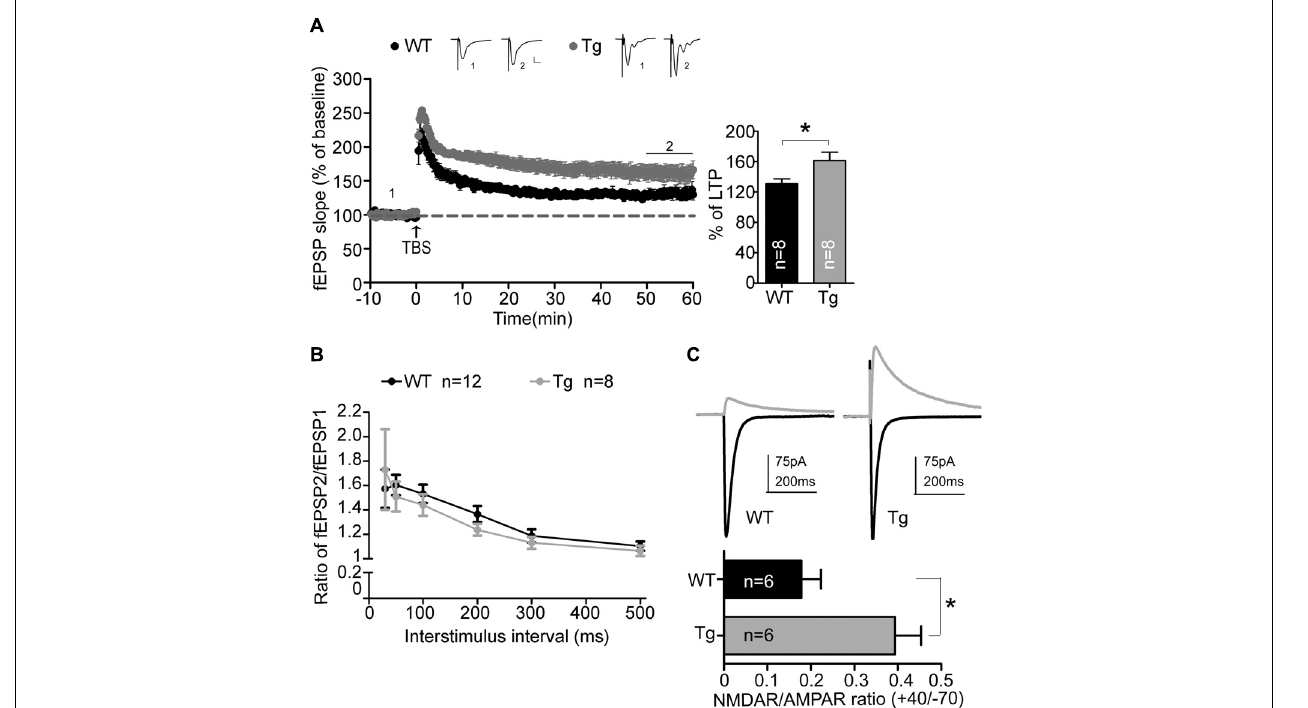
of the last 10 min of recording is shown in the right panel.The data represent the mean plus SEM (for histograms) or ± SEM (for fEPSP slope). * P < 0.05. (B) The paired-pulse facilitation was similar between Sarm1 knockdown and WT mice.The data represent the mean ± SEM. (C) The representative NMDAR (indicated by the gray line) and AMPAR (indicated by the black line) mediated currents fromWT and Sarm1 knockdown CA1 neurons are shown in the upper panel.The ratio of NMDA to AMPA current is shown in the lower panel.The data indicate the mean plus SEM. * P < 0.05.The sample sizes ( n ) are